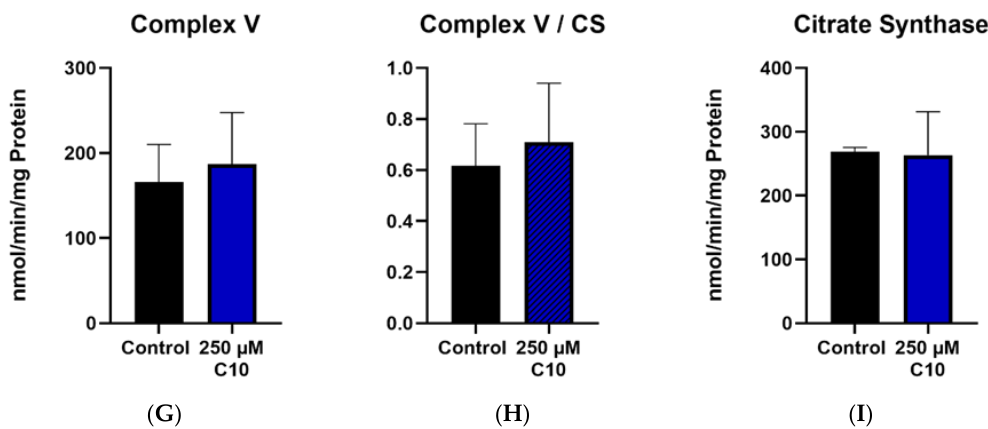
Figure 5. Graphs ( A – C ), G , and I represent maximal enzymatic activities of the respiratory chain complexes I–IV, ATP–synthase (complex V) and citrate synthase (CS). The graphs ( D – F ) and H depict ratios of the enzymatic activities of the respiratory chain to the enzymatic activity of citrate synthase–the mitochondrial marker enzyme. * p < 0.05; ** p < 0.01 ( n = 3–4). Data are represented as mean + SD.